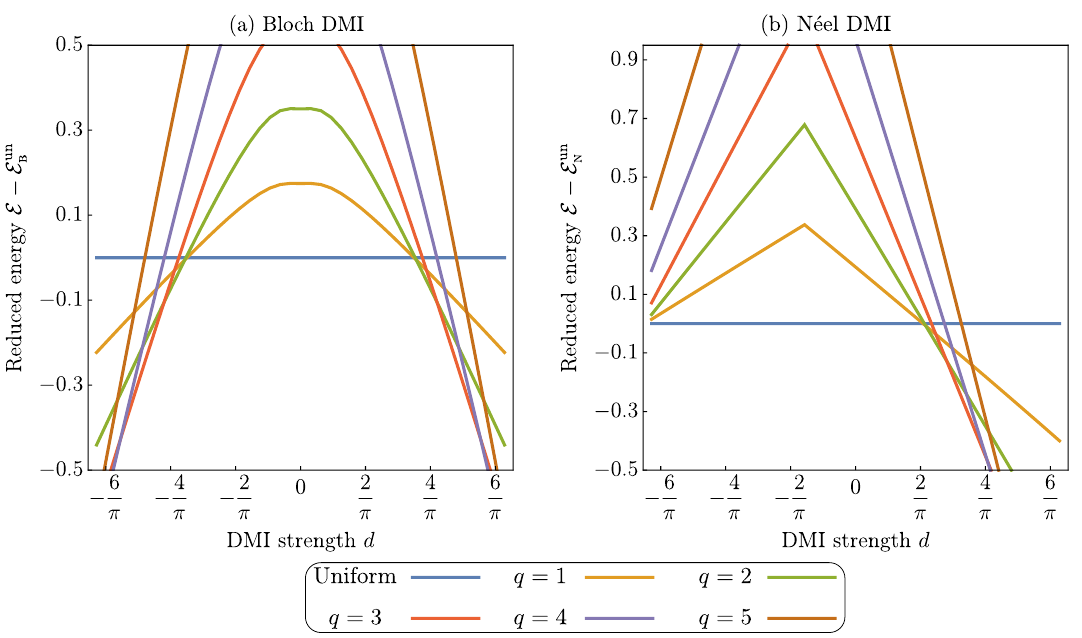
Figure 4: Energies of the cylinder with (cid:99) = 0.25 for Bloch (a) and Néel (b) DMI